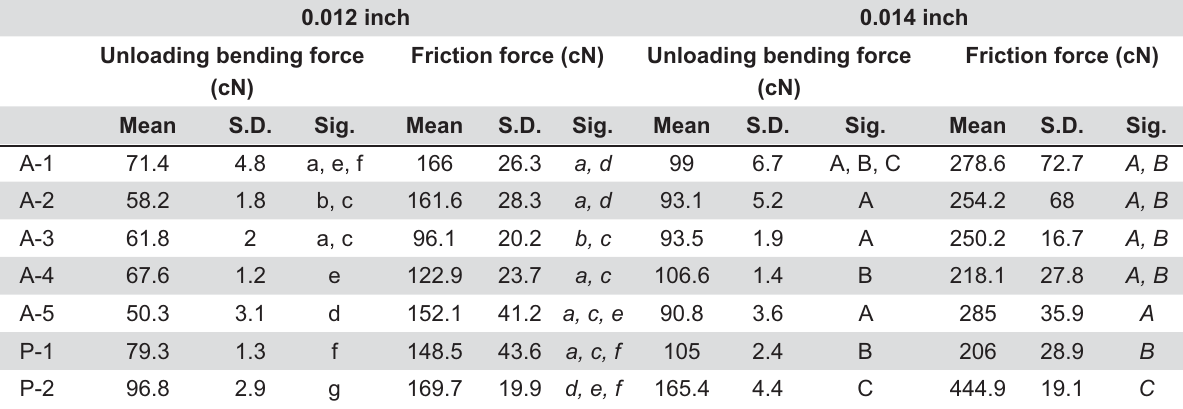
Table 3- Unloading bending and friction forces at a displacement of 2.0 mm